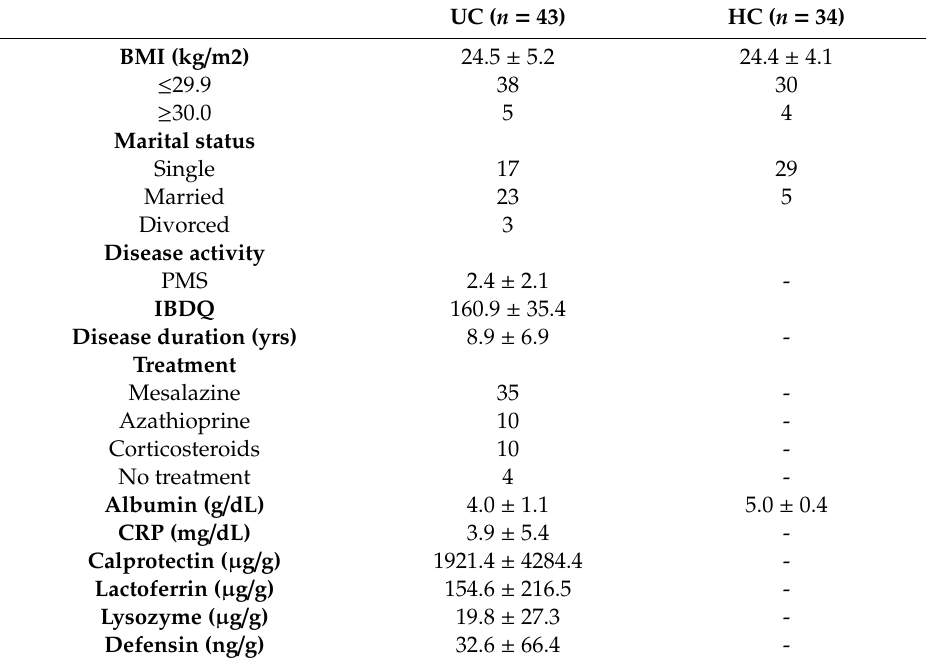
Table 1. Characteristics of patients with UC and